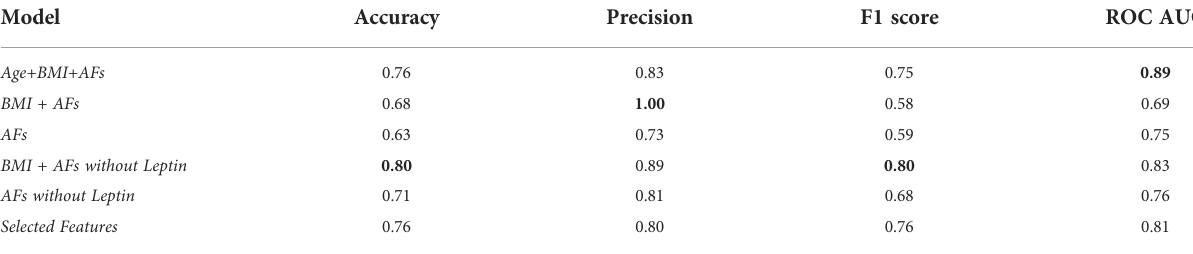
TABLE 6 Performance metrics of multivariate models based on multiple features on test data.